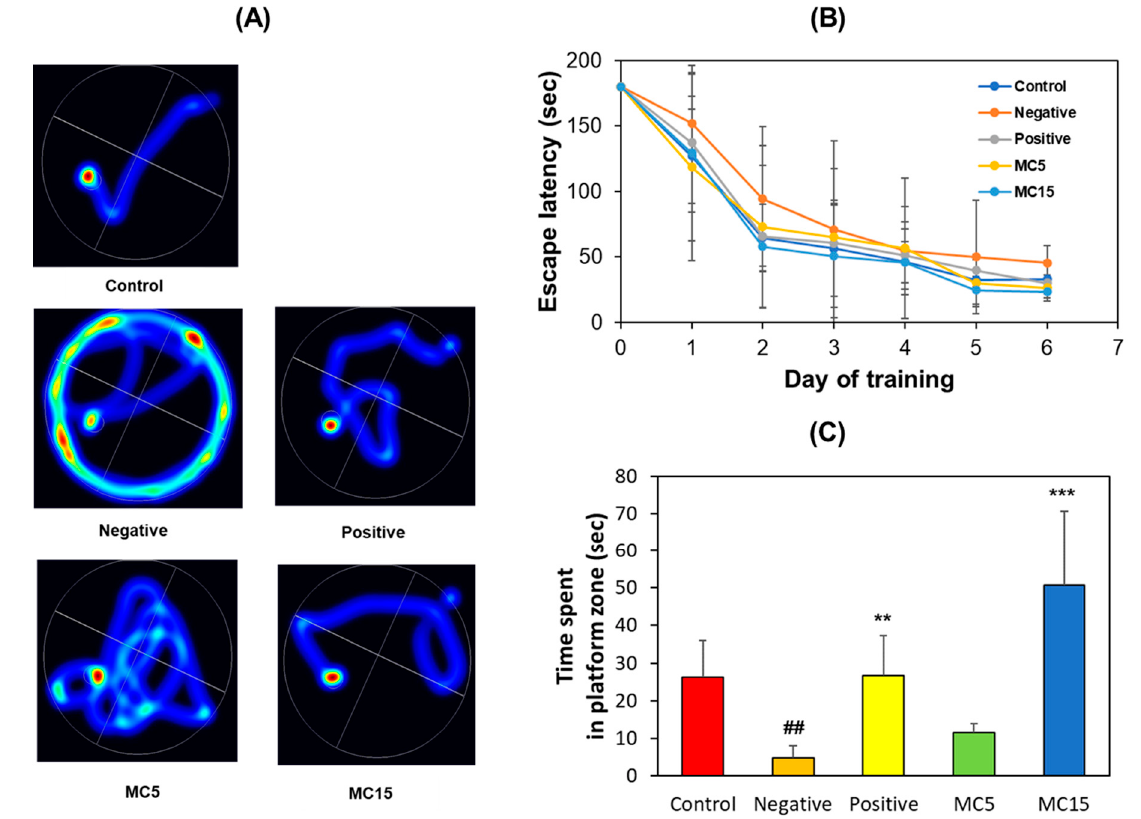
Figure 2. Recovery of long-term memory by MC on MWM test. ( A ) Swimming paths; ( B ) Escape latency for 6 consecutive days; ( C ) Time spent in platform zone in which the platform was removed. Data are presented as mean ± SEM. ## p < 0.01, compared to the control group; ** p < 0.01 and *** p < 0.001, compared to the scopolamine-treated group (n = 8).